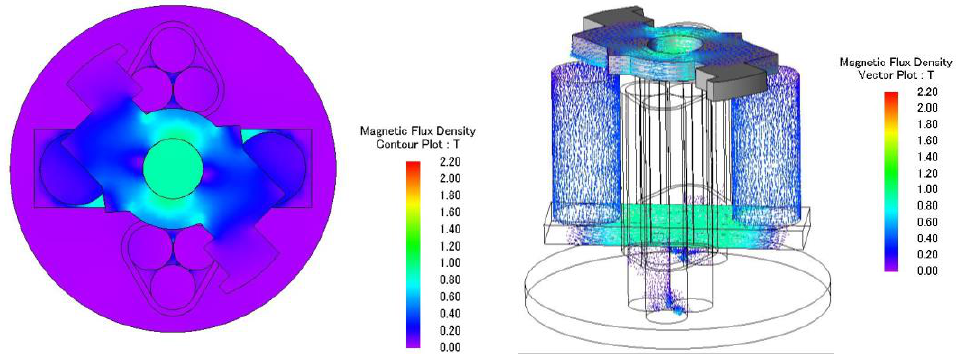
Figure 14. Top view and 3D view of magnetic flux density plots of the motor at a rotating angle of 135°.